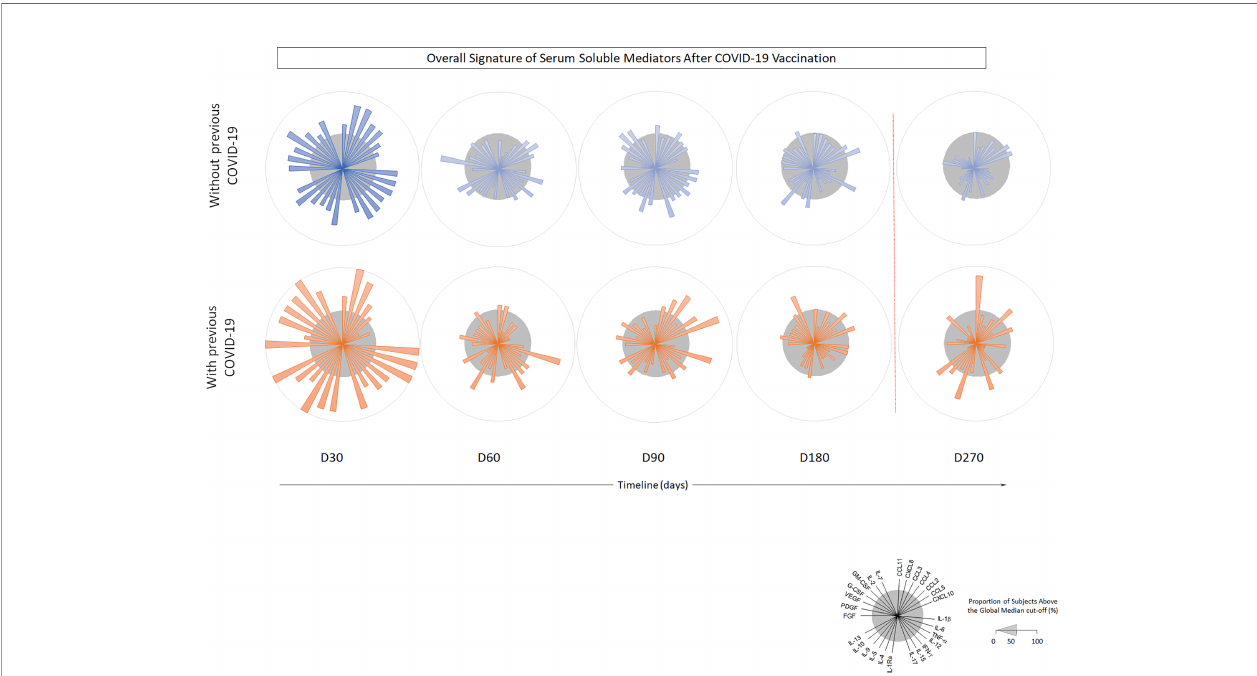
FIGURE 5 | Timeline kinetics of serum biomarkers in participants with or without COVID-19 prior to vaccination with CoronaVac 2 doses + BNT162b2 booster dose. Cross-sectional follow-up analysis of chemokines (CXCL8, CCL11, CCL3, CCL4, CCL2, CCL5, CXCL10); pro-in fl ammatory cytokines (IL-1 b , IL-6, TNF- a , IL- 12, IFN- g , IL-15, IL-17); regulatory cytokines (IL-1Ra, IL-4, IL-5, IL-9, IL-10, IL-13) and growth factors (FGF-basic, PDGF, VEGF, G-CSF, GM-CSF, IL-7, IL-2) was carried out in serum samples. Measurements were performed at distinct times after primary protocol (30-, 60-, 90-, 180- and 270-days post second dose). Biomarkers were presented individually in multiple subpanels and displayed in classes: chemokines, pro-in fl ammatory cytokines, regulatory cytokines, and growth factors. Red dotted lines represent booster dose